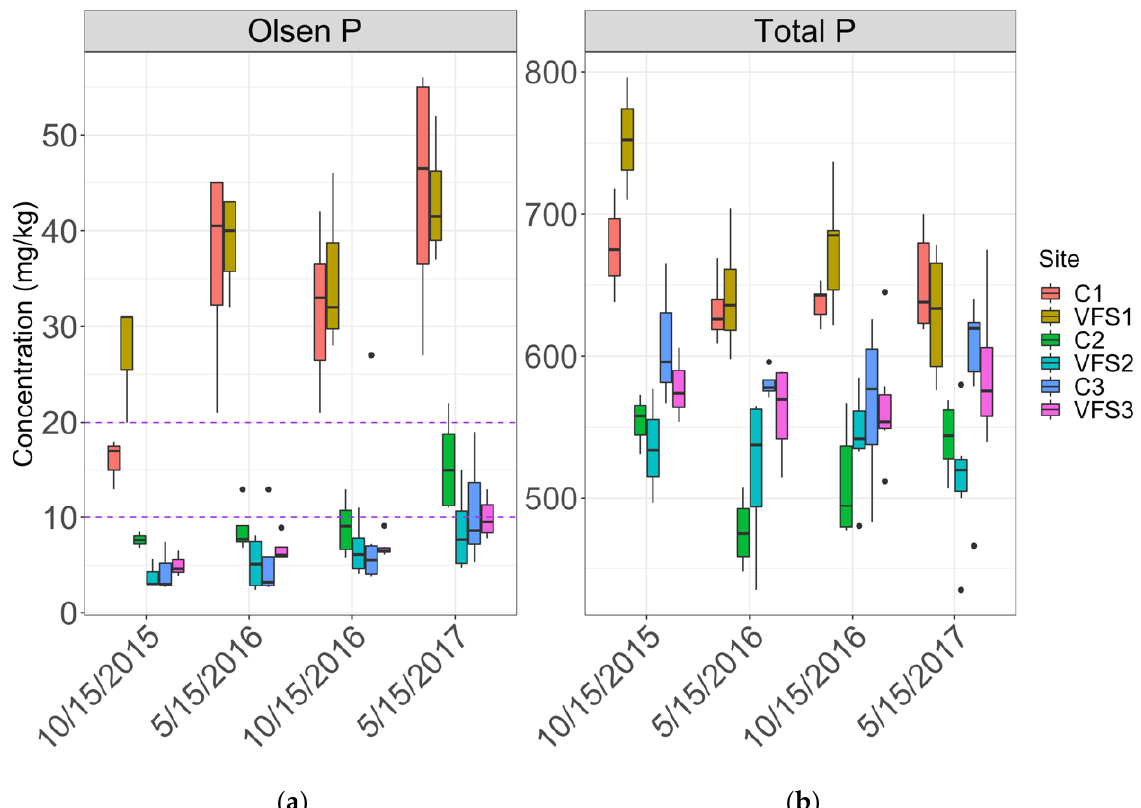
Figure 3. Concentrations of ( a ) Olsen P and ( b ) TP in soils from October 2015 through May 2017 in control (C) and vegetated filter strips (VFS). Solid lines indicate the median, error bars represent standard error, and dots represent outliers. The dashed purple lines denote the range of optimum Olsen P values for this region.